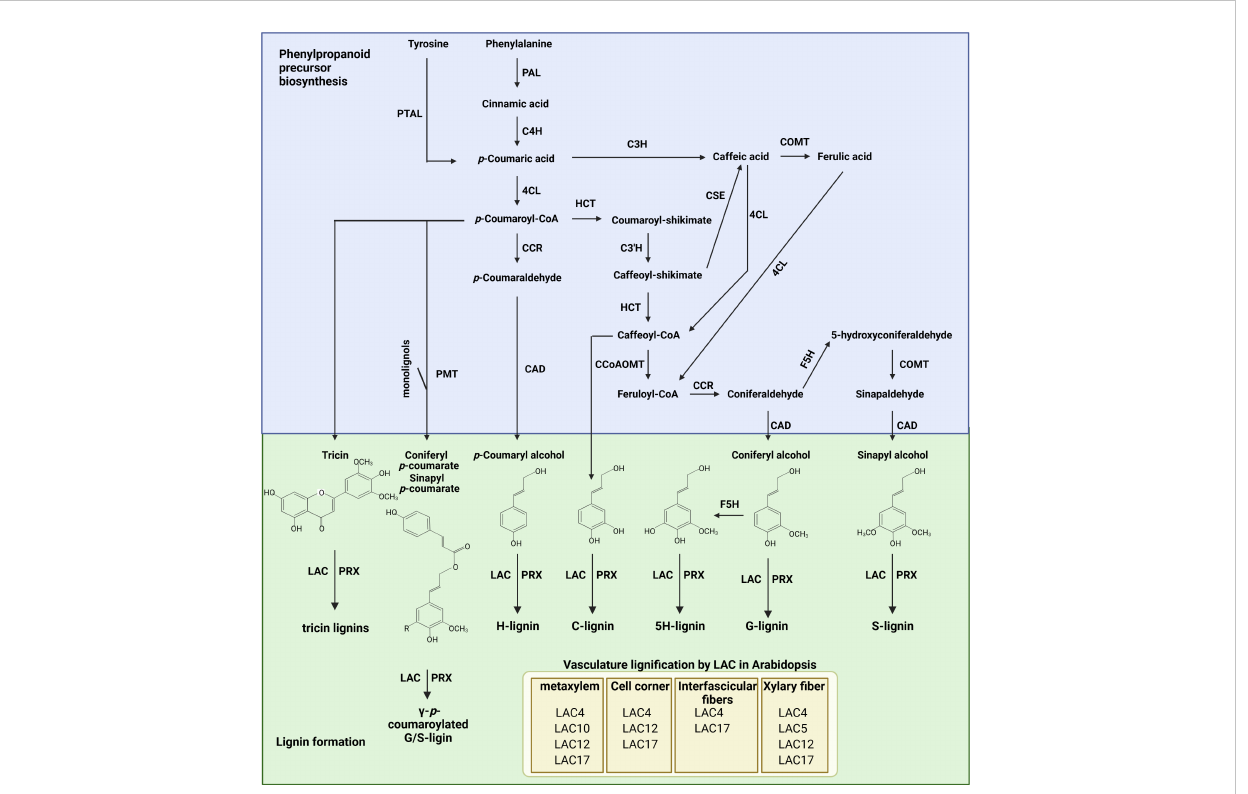
FIGURE 1 The lignin biosynthesis pathway from phenylalanine in plants. PAL, phenylalanine ammonia-lyase; PTAL, phenylalanine tyrosine ammonia lyase; C4H, cinnamic acid 4-hydroxylase; 4CL, 4-Coumarate: CoA ligase; CCR, cinnamoyl-CoA reductase; HCT, quinate/shikimate p -hydroxycinnamoyltransferase; C3 ’ H, p -coumaroylshikimate 3 ’ -hydroxylase; C3H, coumarate 3-hydroxylase; CSE, caffeoyl shikimate esterase; CCoAOMT, caffeoyl-CoA O - methyltransferase; F5H, ferulate 5-hydroxylase; COMT, caffeic acid O -methyltransferase; CAD, cinnamyl alcohol dehydrogenase; PMT, p -coumaroyl-CoA: monolignol transferase; LAC, laccase; PRX, peroxidase. Arabidopsis LACs involved in ligni fi cation of vascular tissue are illustrated on the bottom. The fi gure was created with Biorender